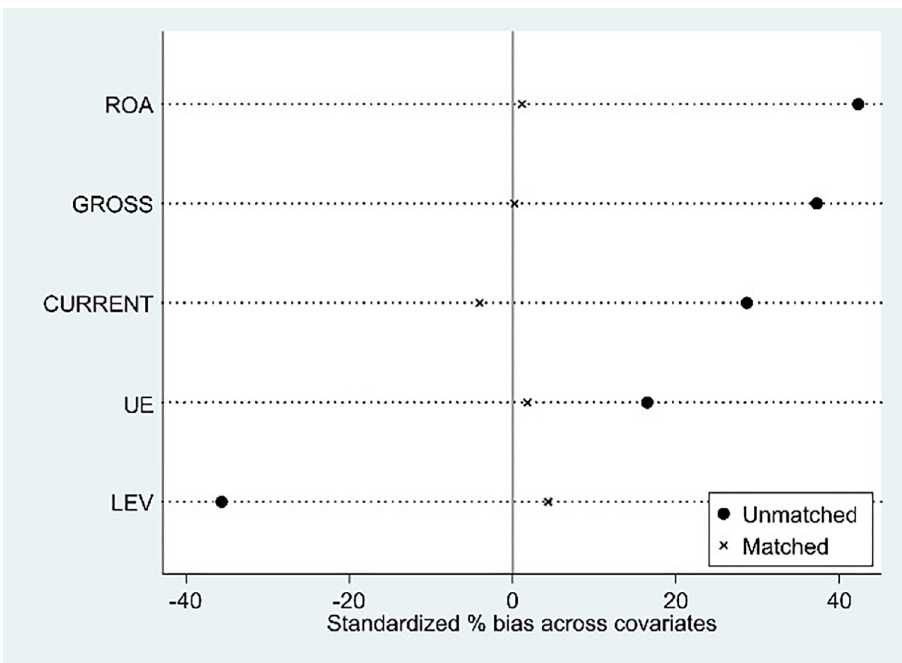
Fig 3. Comparison of covariate differences before and after